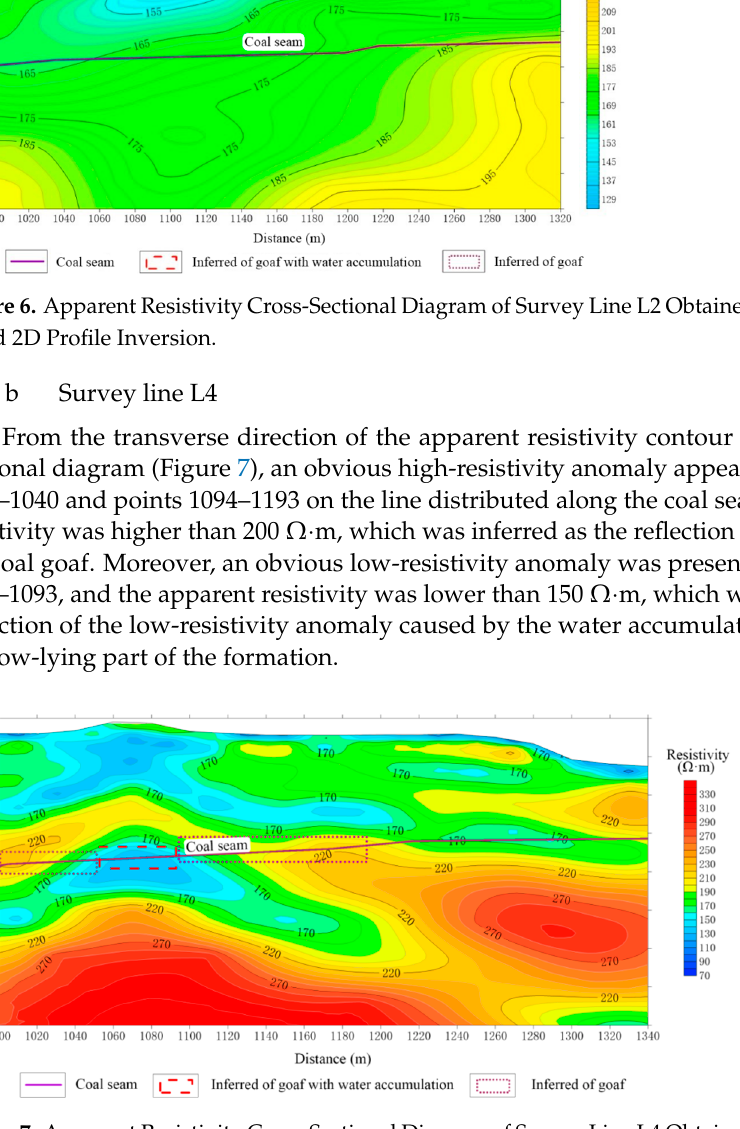
Figure 7. Apparent Resistivity Cross-Sectional Diagram of Survey Line L4 Obtained Through CSAMT-based 2D Profile Inversion.